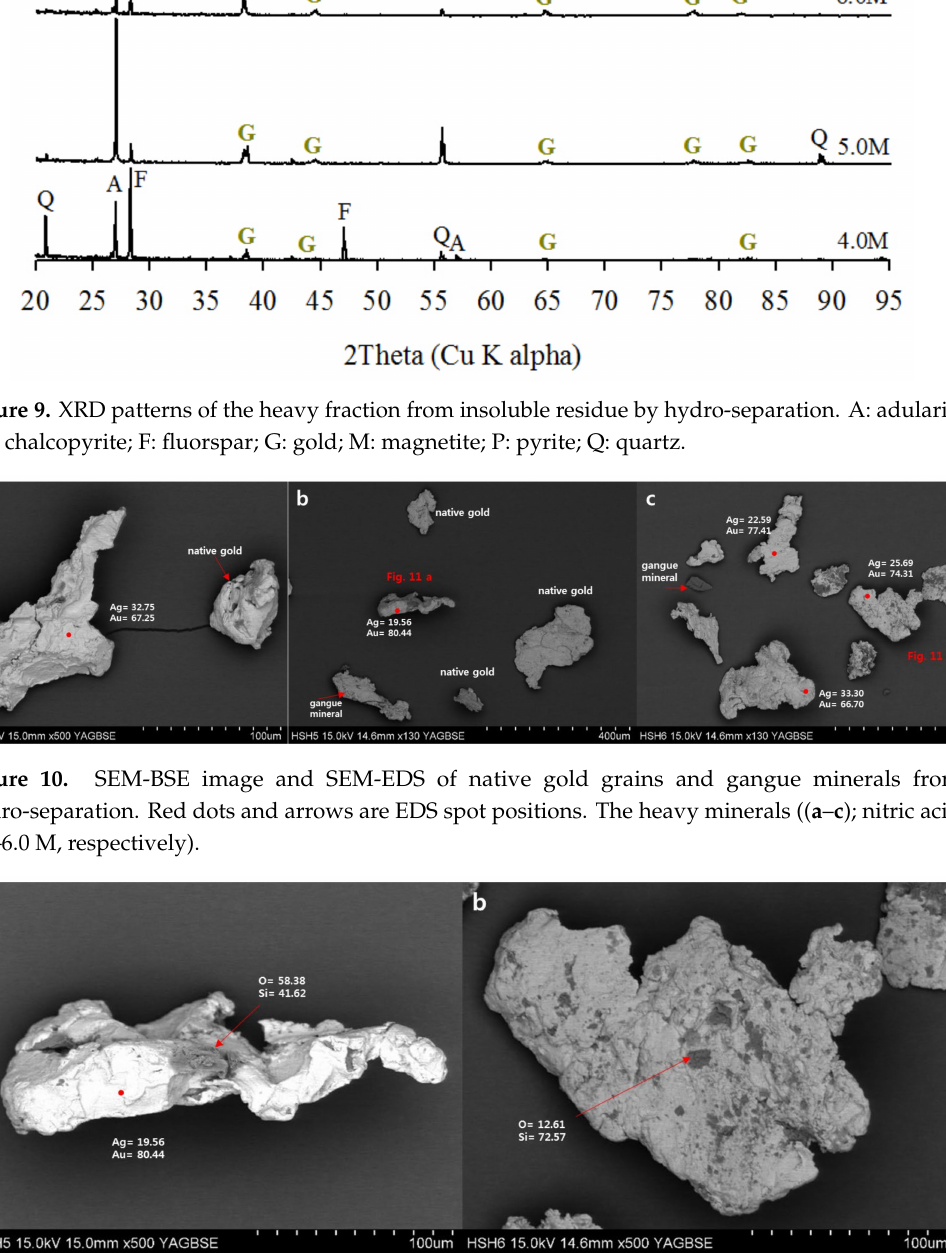
Figure 11. Close up SEM-BSE image of native gold particles in Figure 10b,c. Red dots and arrows are EDS spot positions, and the numbers are concentration of elements in wt.%. ( a ) Figure 10b; ( b ) Figure